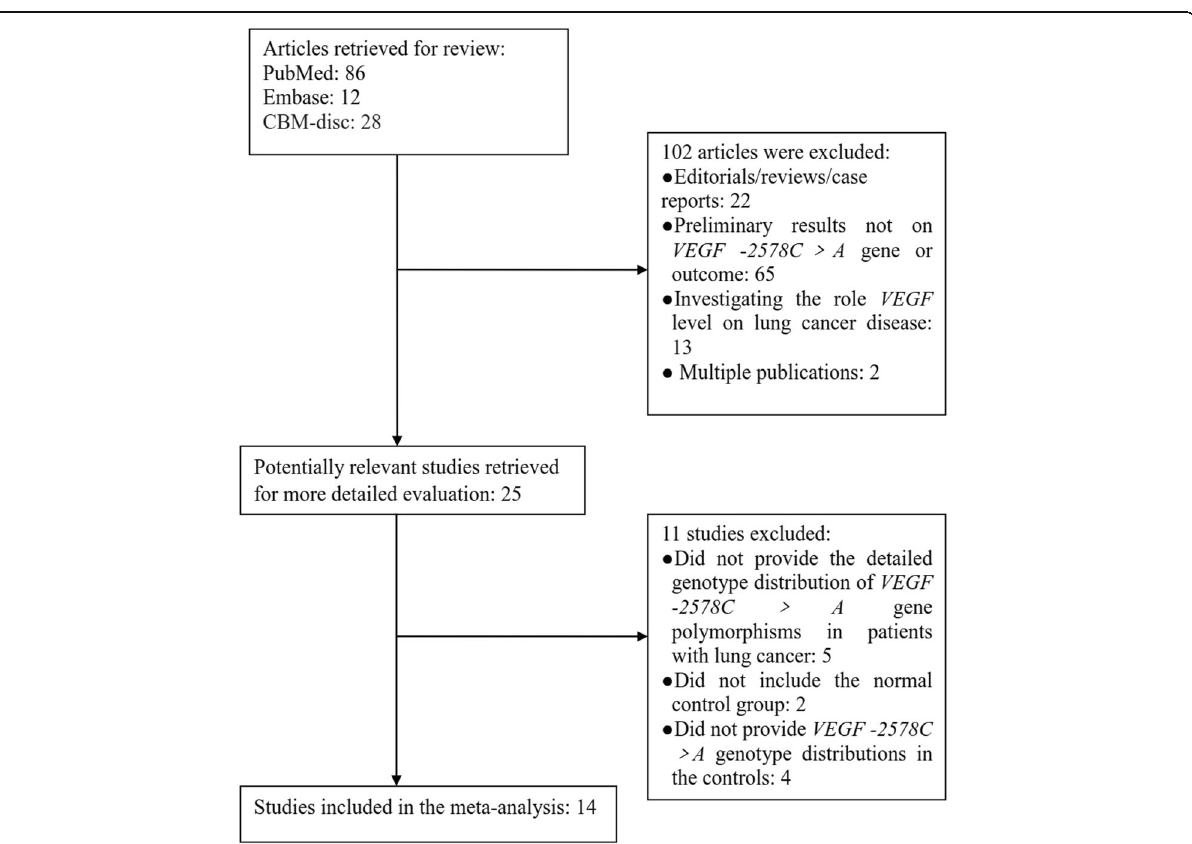
Fig. 1 Flow chart of the study search and